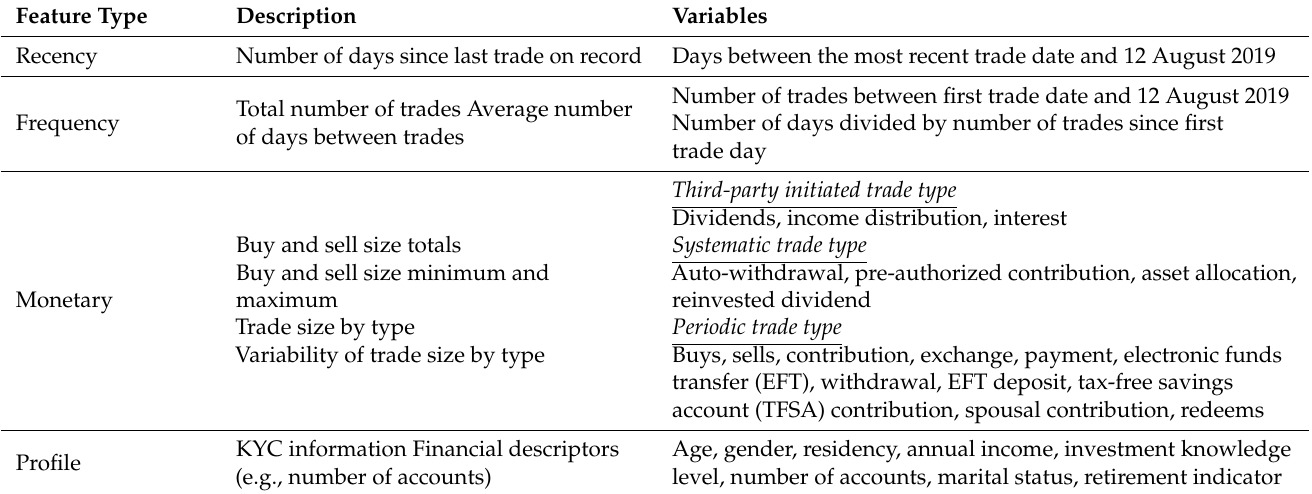
Table 4. The recency, frequency, monetary profile (RFMP) features engineered from the